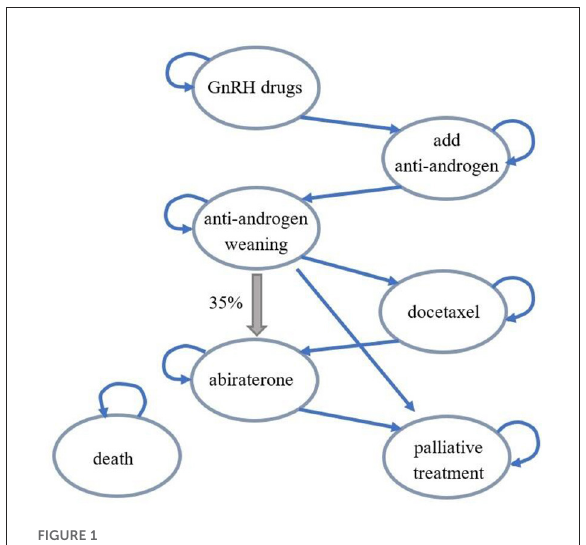
FIGURE1 Structural diagram of the Chinese adaptation model.